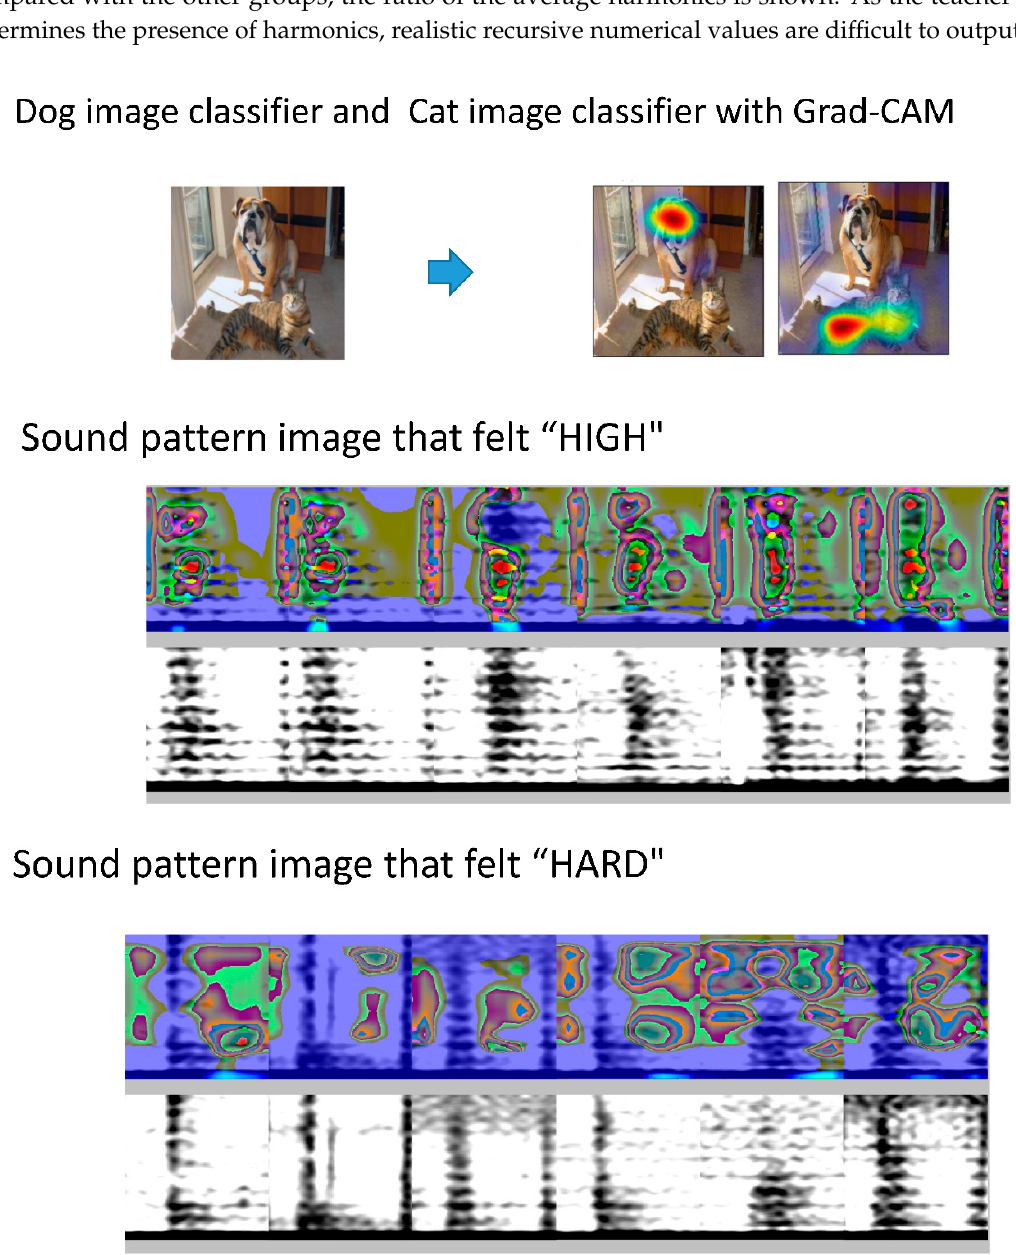
Figure 6. Grad-CAM for visualization of characteristic sites. With Grad-CAM, if the image is judged to be a dog using a dog image classifier, the image is colored. The same applies to a cat image classifier. When the characteristic portion of the sound pattern image that felt “high” is visualized, the 250–750 Hz region in the systole is emphasized in the heat map. In the case of a sound pattern image that felt “hard,” the silent region in the diastolic area was emphasized.